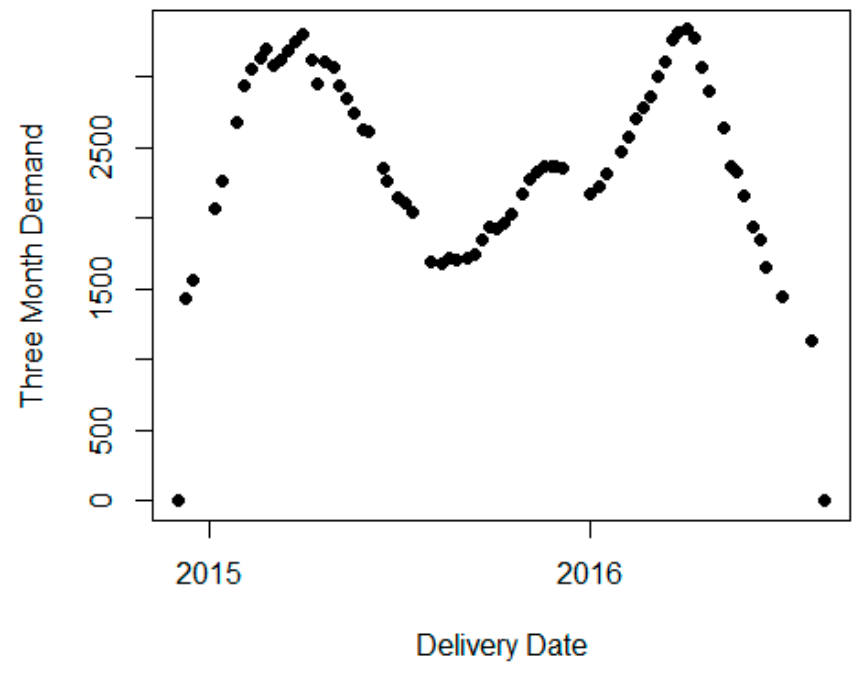
Figure 2. Total demand in the last three months.